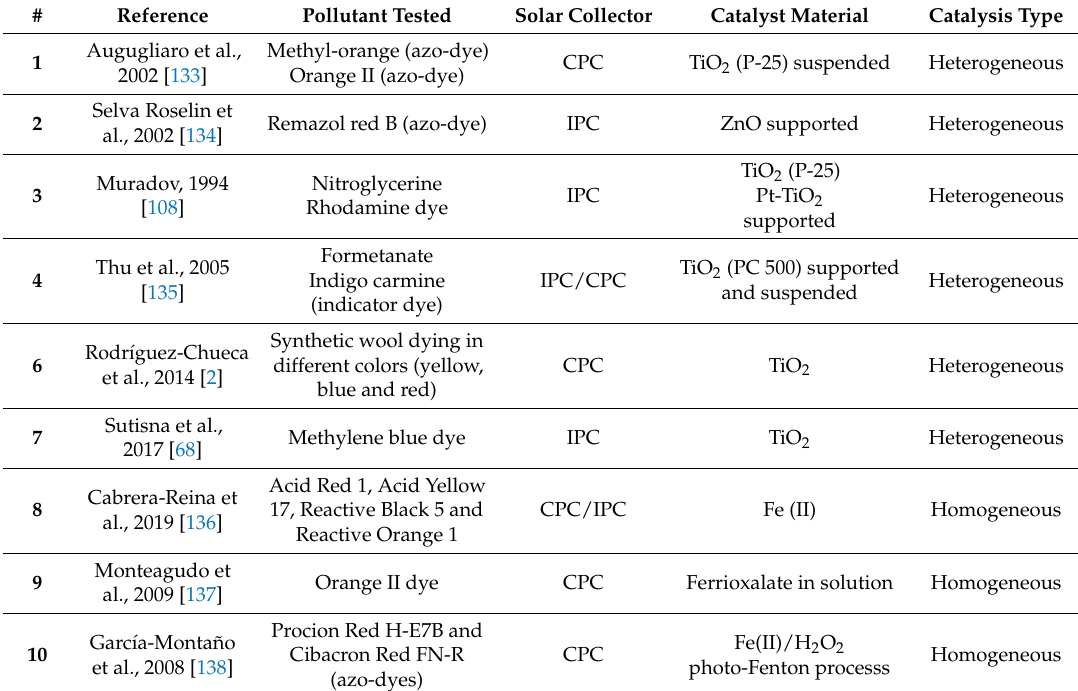
Table 4. BROCs model wastewaters (Dyes).